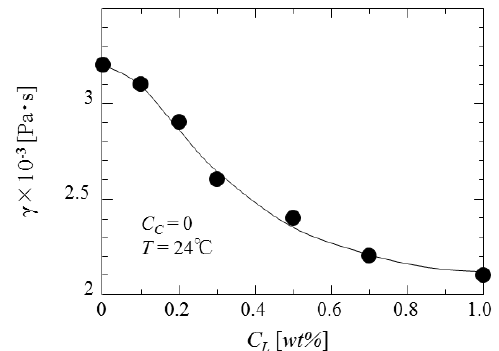
Figure 7. Dependence of interfacial tension on surfactant